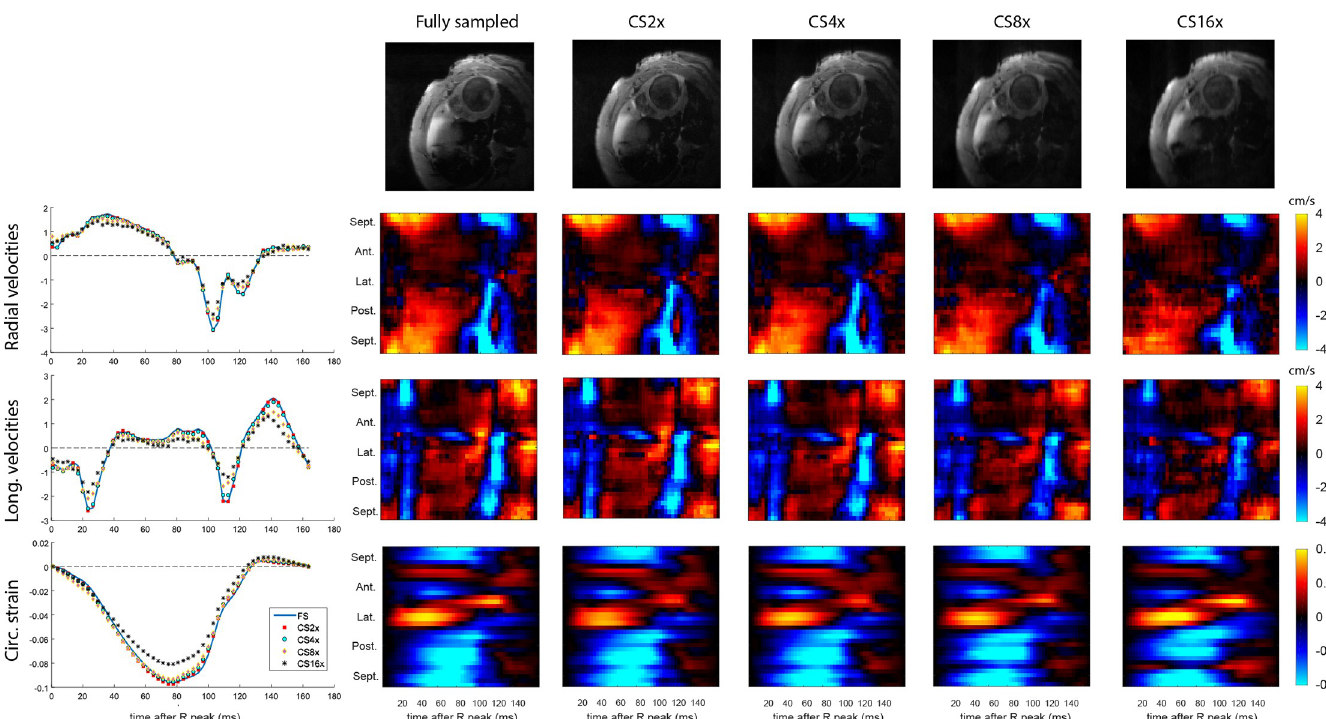
Fig 4. Retrospective CS results from a representative infarcted heart. Direct comparisons of magnitude images (1 st row) as well as the transmural average of global and regional radial velocities (2 nd row), longitudinal velocities (3 rd row), and circumferential strain values (4 th row) for a variety of undersampling factors.